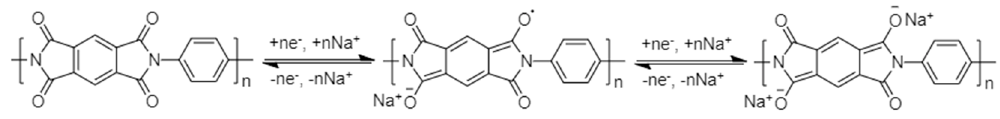
Scheme 1. Schematic representation of the redox reaction of aromatic polyimides.